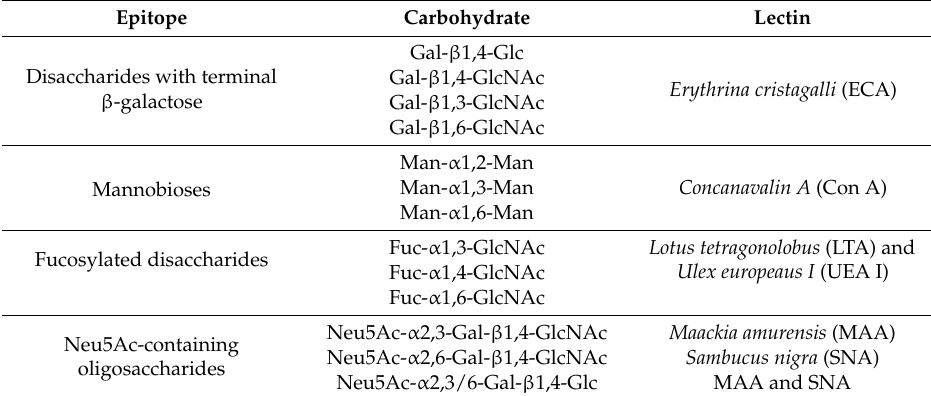
Table 1. Carbohydrate epitopes commonly encountered in mammalian specimens and corresponding lectins with well-defined binding